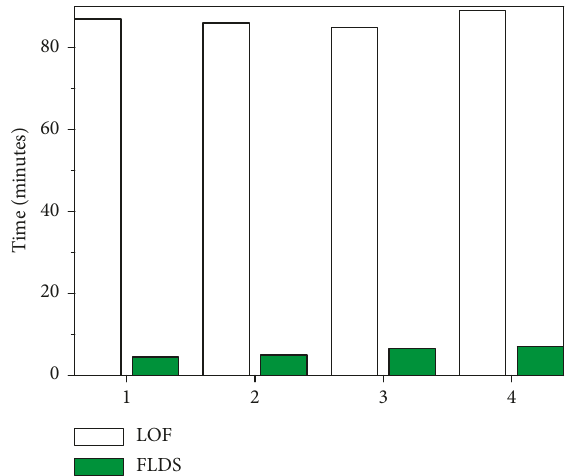
Figure 7: Running time comparison between FLDS and LOF for four 2D data sets.